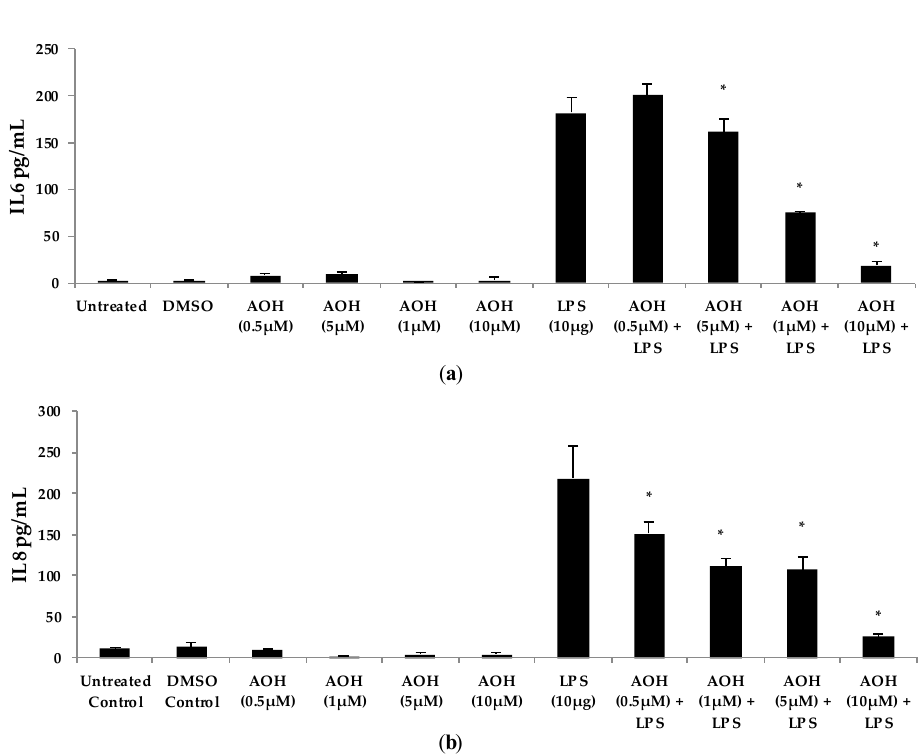
Figure A1. Dose-dependent analysis of the alternariol (AOH) response. Lipopolysaccharide (LPS) was added 2 h after AOH. BEAS-2B cells were seeded at a density of 500,000 cells/well. Cells were treated with 0.5–10 μ M of AOH in the presence and absence of 10 μ g of LPS to measure the cytokine levels released. Cell densities were 5 × 10 5 cells/well, and they were incubated for 24 h under normal conditions at 37 °C, 5% CO 2 . Cells treated with AOH showed a marked suppression of cytokines both in the presence and absence of LPS. ( a ) IL6 measured by enzyme-linked immunosorbent assay (ELISA); ( b ) IL8 measured by ELISA. An * indicates p < 0.05 according to Student’s t -test when comparing LPS + AOH treatments to LPS-induced control.